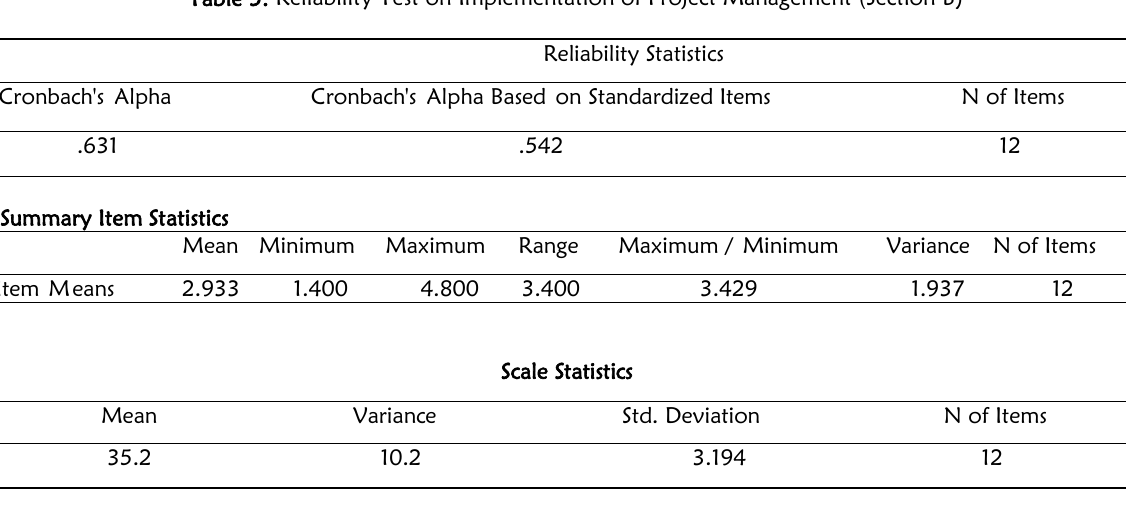
Table 5: Reliability Test on Implementation of Project Management (Section